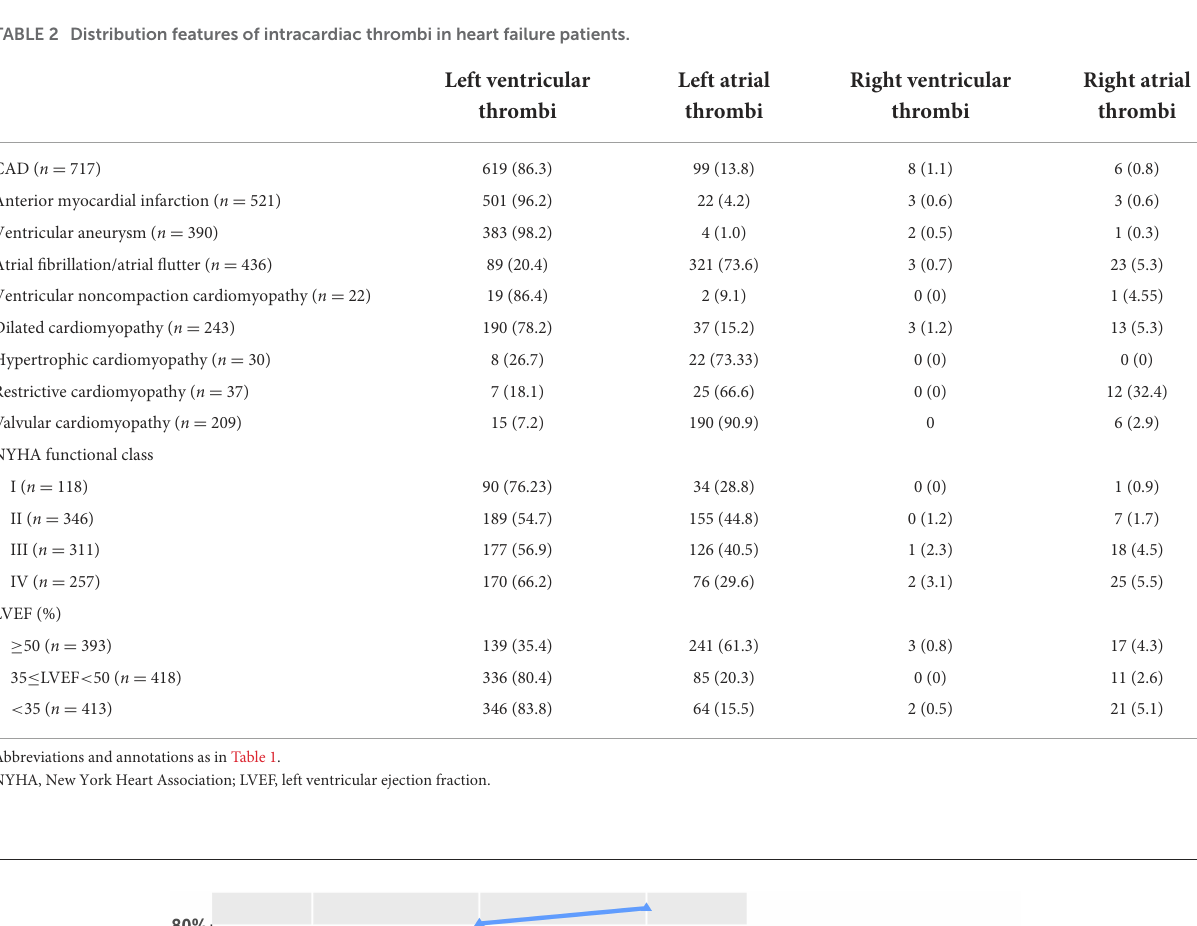
TABLE 2 Distribution features of intracardiac thrombi in heart failure patients.